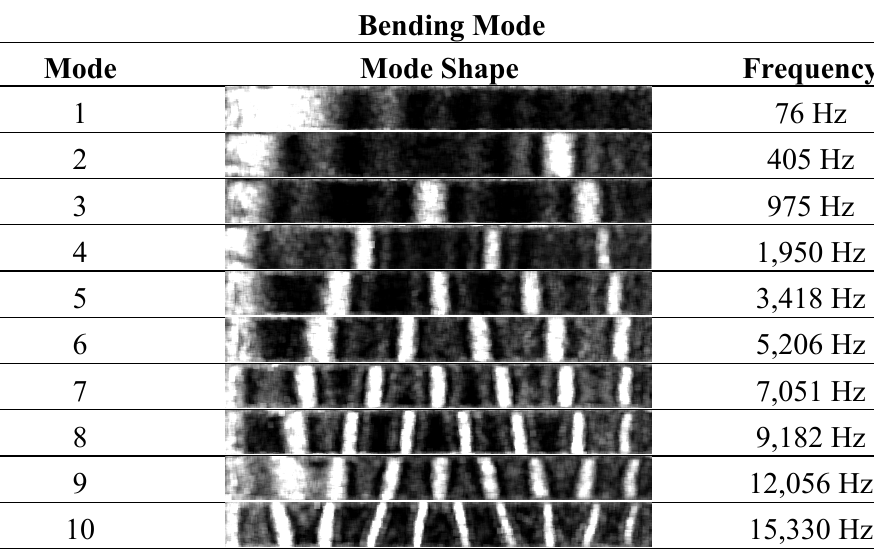
Table 2. Bending modes of the smart cantilever beam .